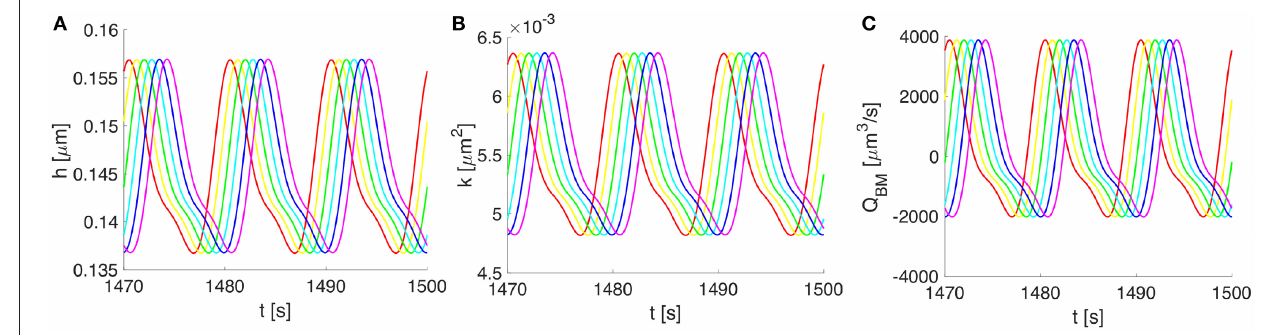
FIGURE 5 | Vasomotion-induced deformation and flows along the BM for three cycles of vasomotion. (A) Oscillations in time of the upper-half thickness of the BM, (B) deformation dependent permeability of the BM, and (C) the corresponding volumetric flow rate along the whole compartment of BM. Progressive change in color from red to magenta shows six distinct spatial points over 750 µ m (out of a 2,000 µ m